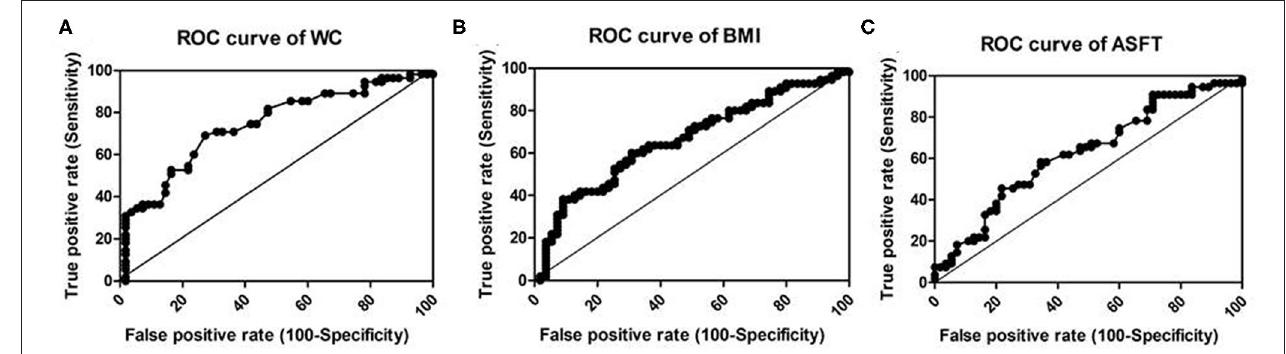
FIGURE 4 | Receiver–operator characteristic curve (ROC) to illustrate the values of WC (A) , BMI (B) , and ASFT (C) as predictors of HGFL in children with NAFLD. The line in the diagonal presents the ROC curve of a random predictor (AUC: 0.5). Among the three body mass parameters, WC has the greatest power to predict HGFL.